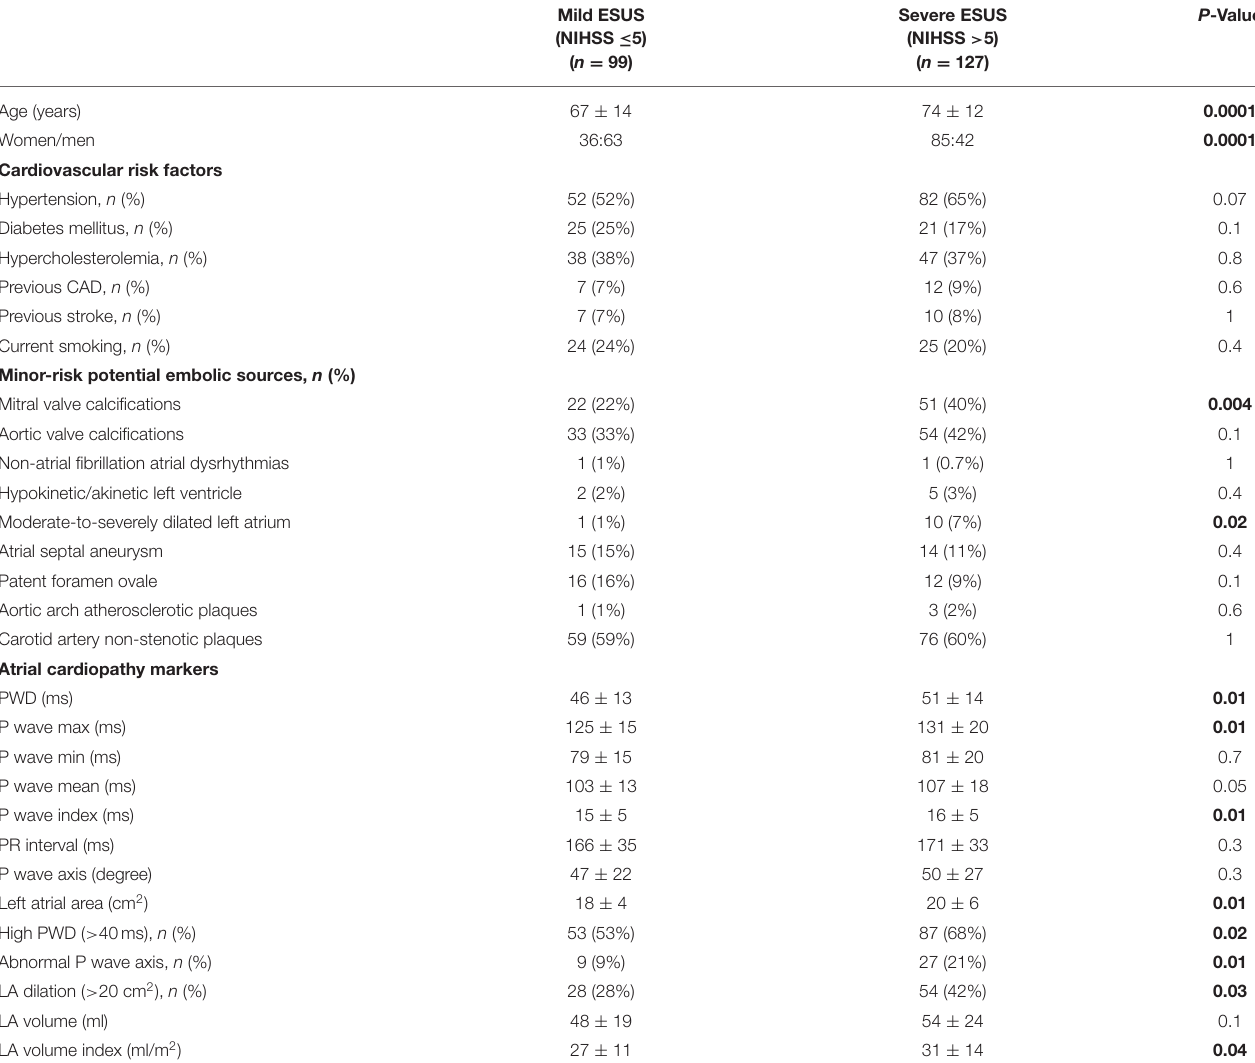
TABLE 1 | Characteristics of ESUS patients with mild and severe neurological